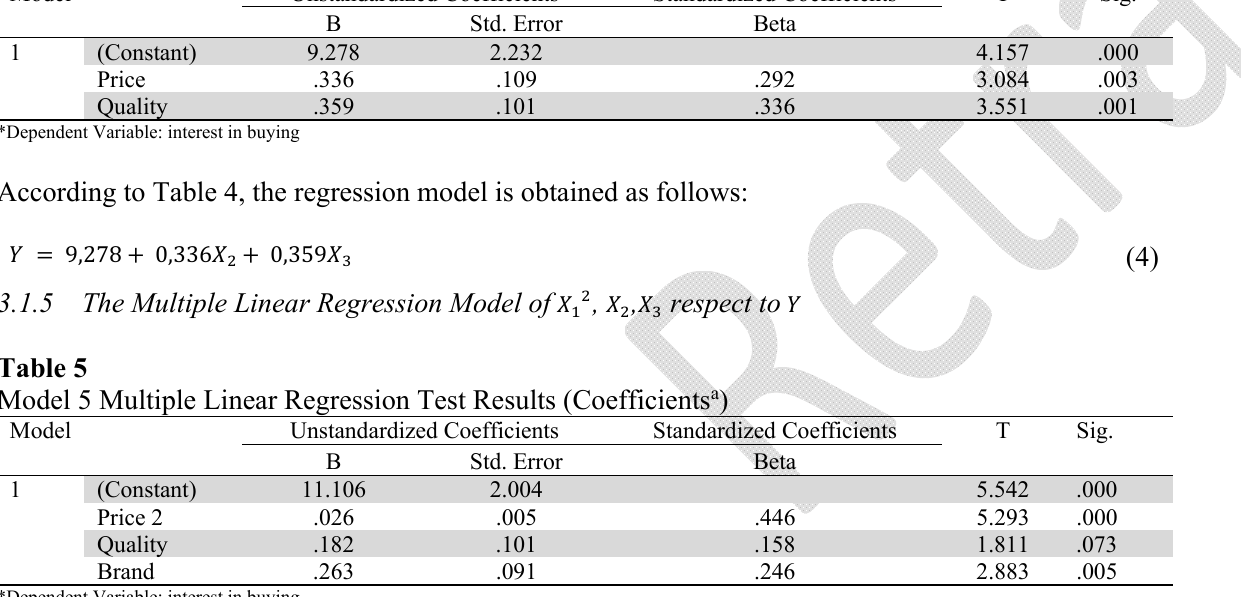
Model 4 Multiple Linear Regression Test Results (Coefficients a ) Model